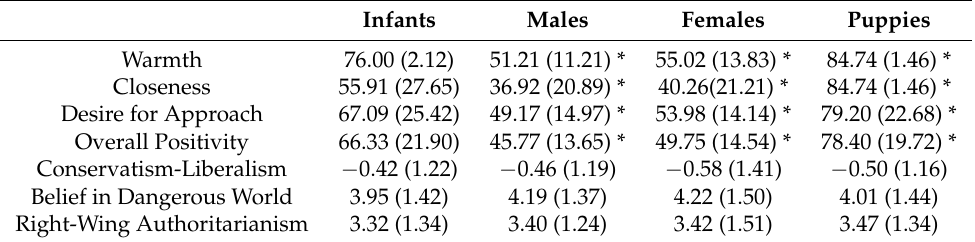
Table 1. Means and standard deviations (in parentheses) across the four face stimuli conditions (females, males, infants, and puppies). Asterisk notation (*) indicates that the mean for a given facial stimuli condition (females, males, puppies) differs significantly from the infant facial stimuli condition ( p <